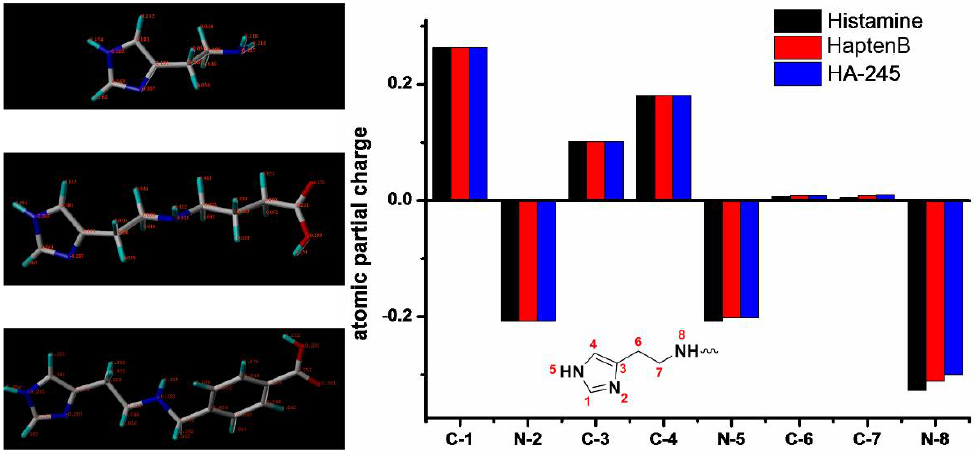
Figure 2. Computed partial atomic charges of histamine (HA), Hapten B and hapten HA-245. Only those atoms that are shared by these structures are displayed. Hydrogen atoms are not